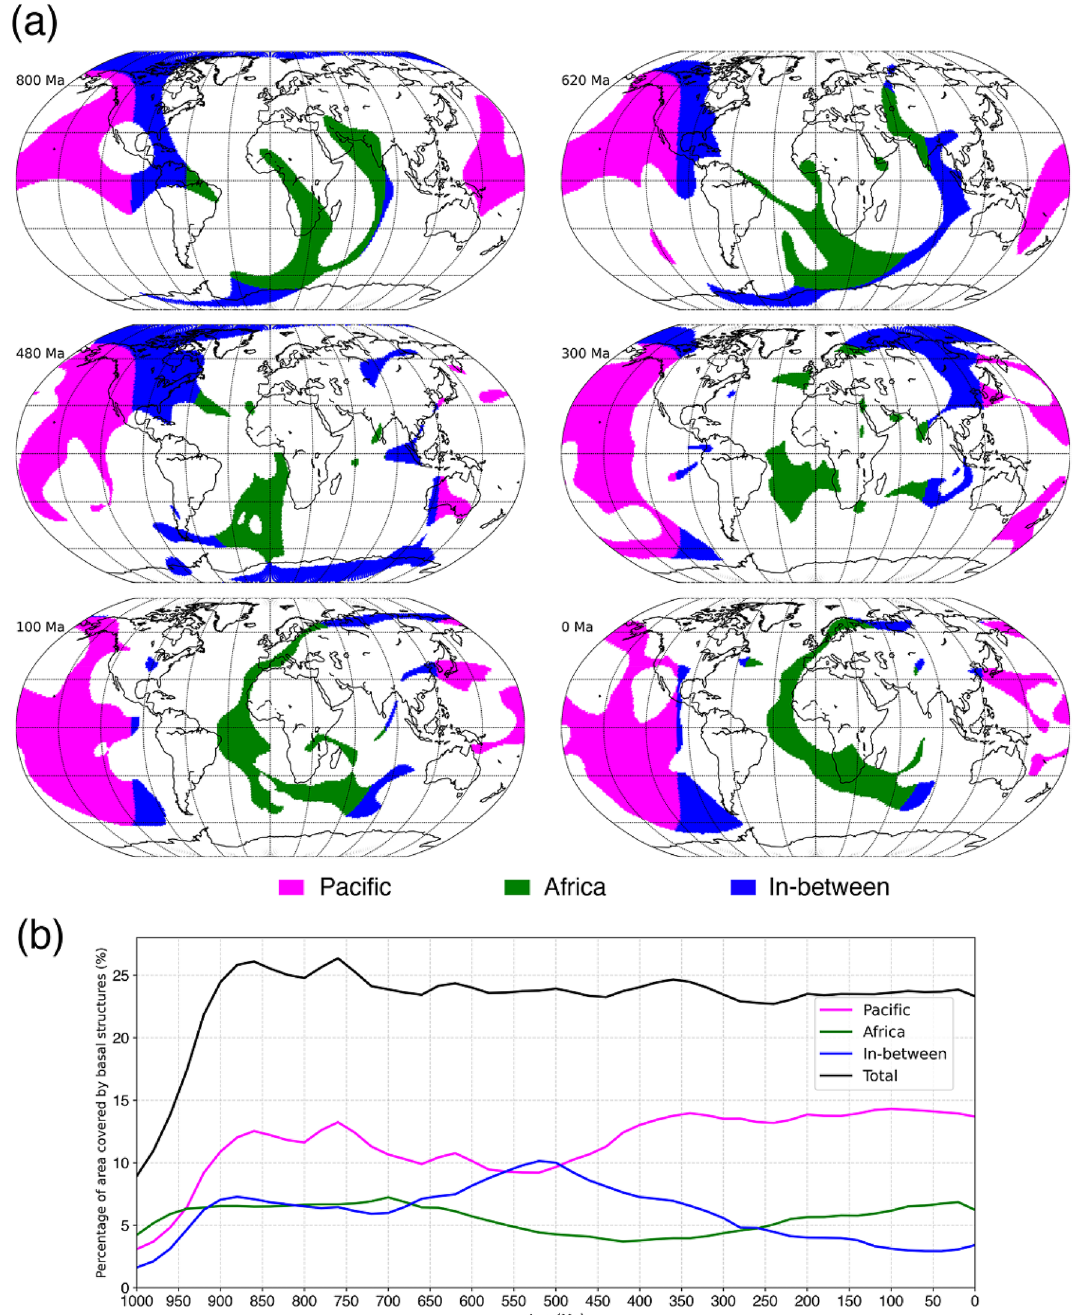
lat = 11° E/0°, with a radius of 70.5°), below the Pacific Ocean (centred on lon/lat = 169° W/0°, with a radius of 70.5°), and the ring in-between. (b) Percentage of each of the three equal-area parts covered by